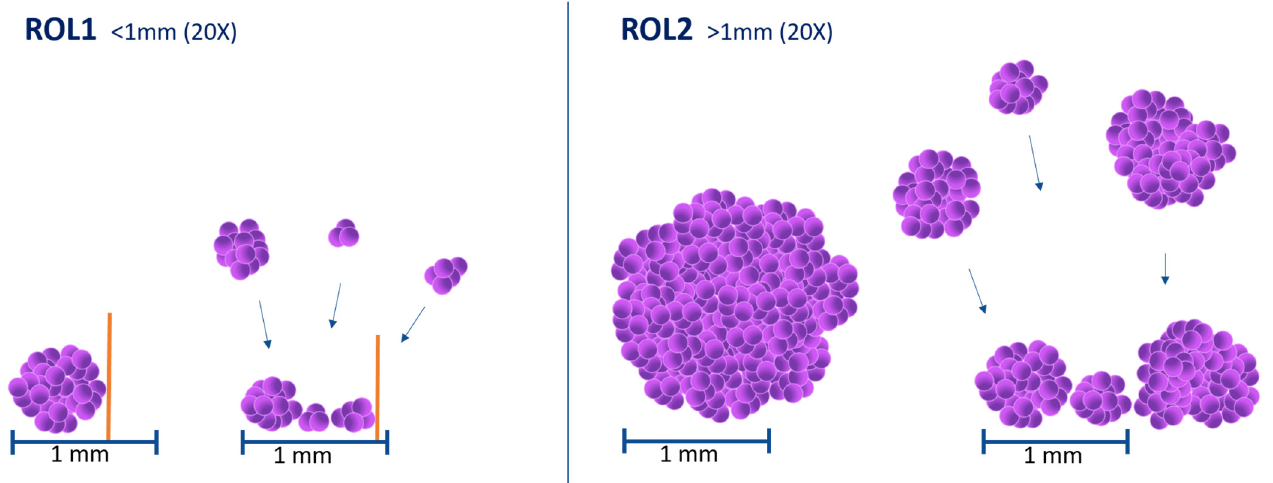
Figure 1. ROL system for substaging pT1 high-grade urothelial bladder carcinoma. ROL1 corresponded to a single or multiple foci of LP invasion extending for less than 1.0 mm at maximum extension and in any direction. ROL2 refers to a single or multiple foci of LP invasion measuring more than 1.0 mm. To simplify, the diameter of a 20x-power field (approximately 1.0 mm) can be employed. The sizes of the individual foci were summed to determine the ROL in cases of multifocal LP invasion. ROL: Rete Oncologica Lombarda; LP: lamina